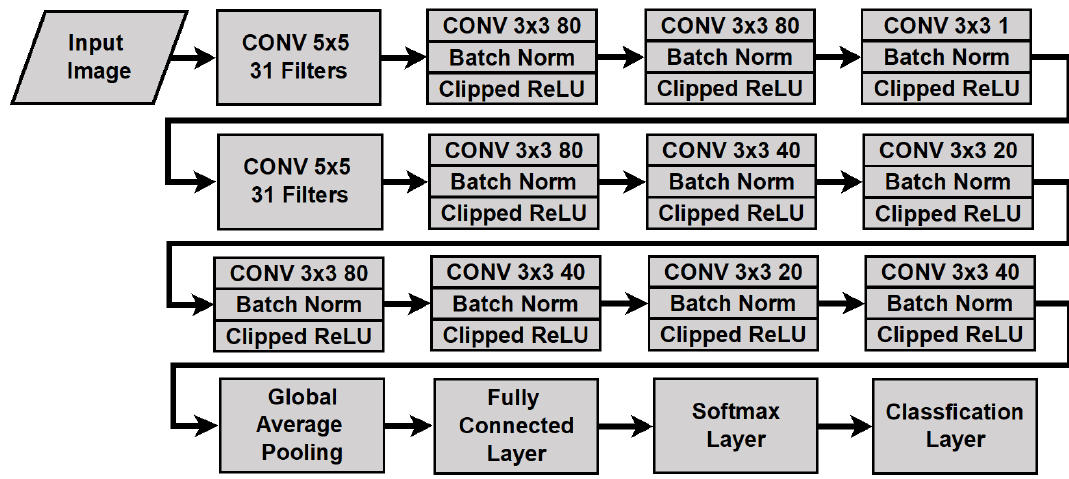
Figure 4. Block diagram of the proposed scheme.